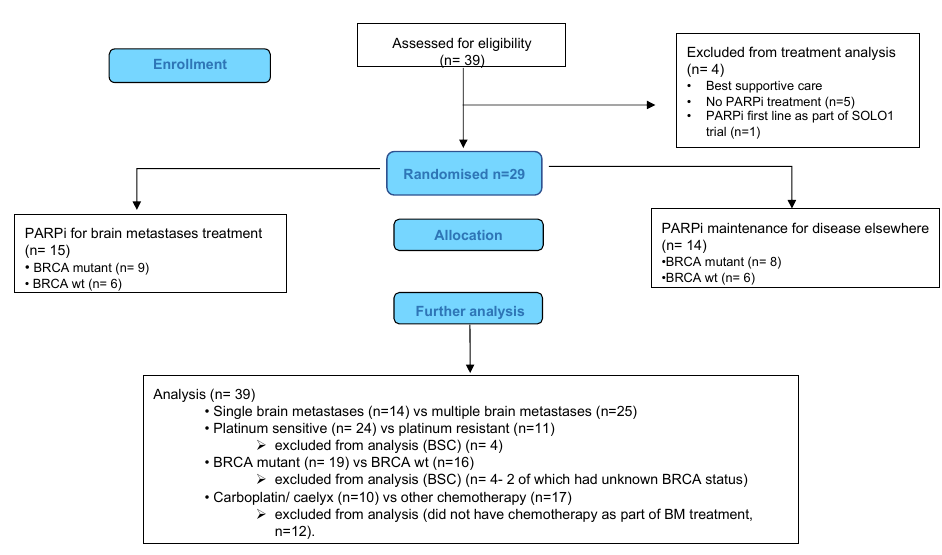
Figure 1 . CONSORT diagram to describe patient groups . Figure 1. CONSORT diagram to describe patient Table 1. Baseline clinical characteristics of 39 patients with EOC and BM.